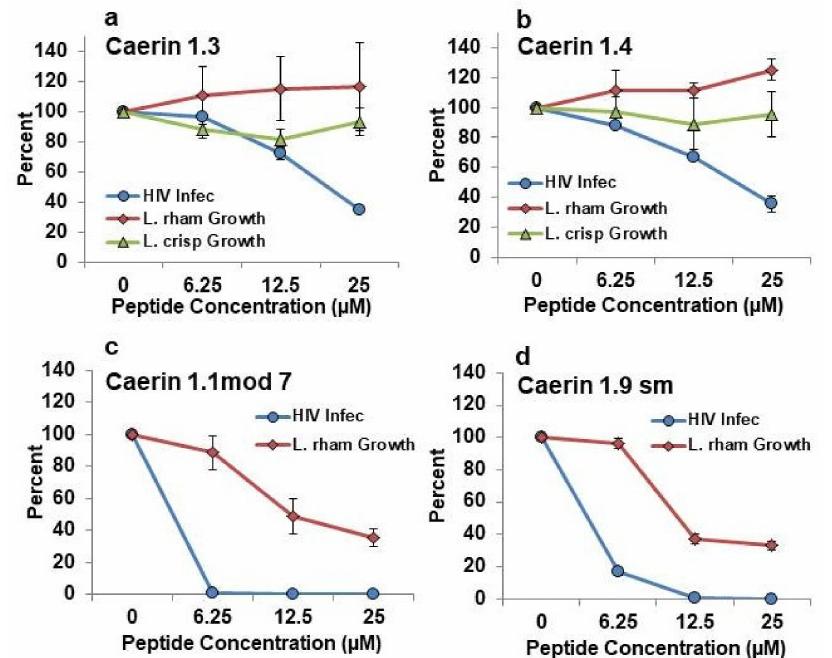
Figure 6. Comparison of the e ff ects of caerin 1 peptides on percent of HIV infection of target T cells (blue) with percent growth of Lactobacillus rhamnosus (red) and Lactobacillus crispatus (green). ( a ) caerin 1.3; ( b ) caerin 1.4; ( c ) caerin 1.1 mod 7; ( d ) caerin 1.9 sm. HIV percent infection was previously published [11] and average percent growth of the lactobacilli in the presence of each peptide is new for this study and presented above in Figures